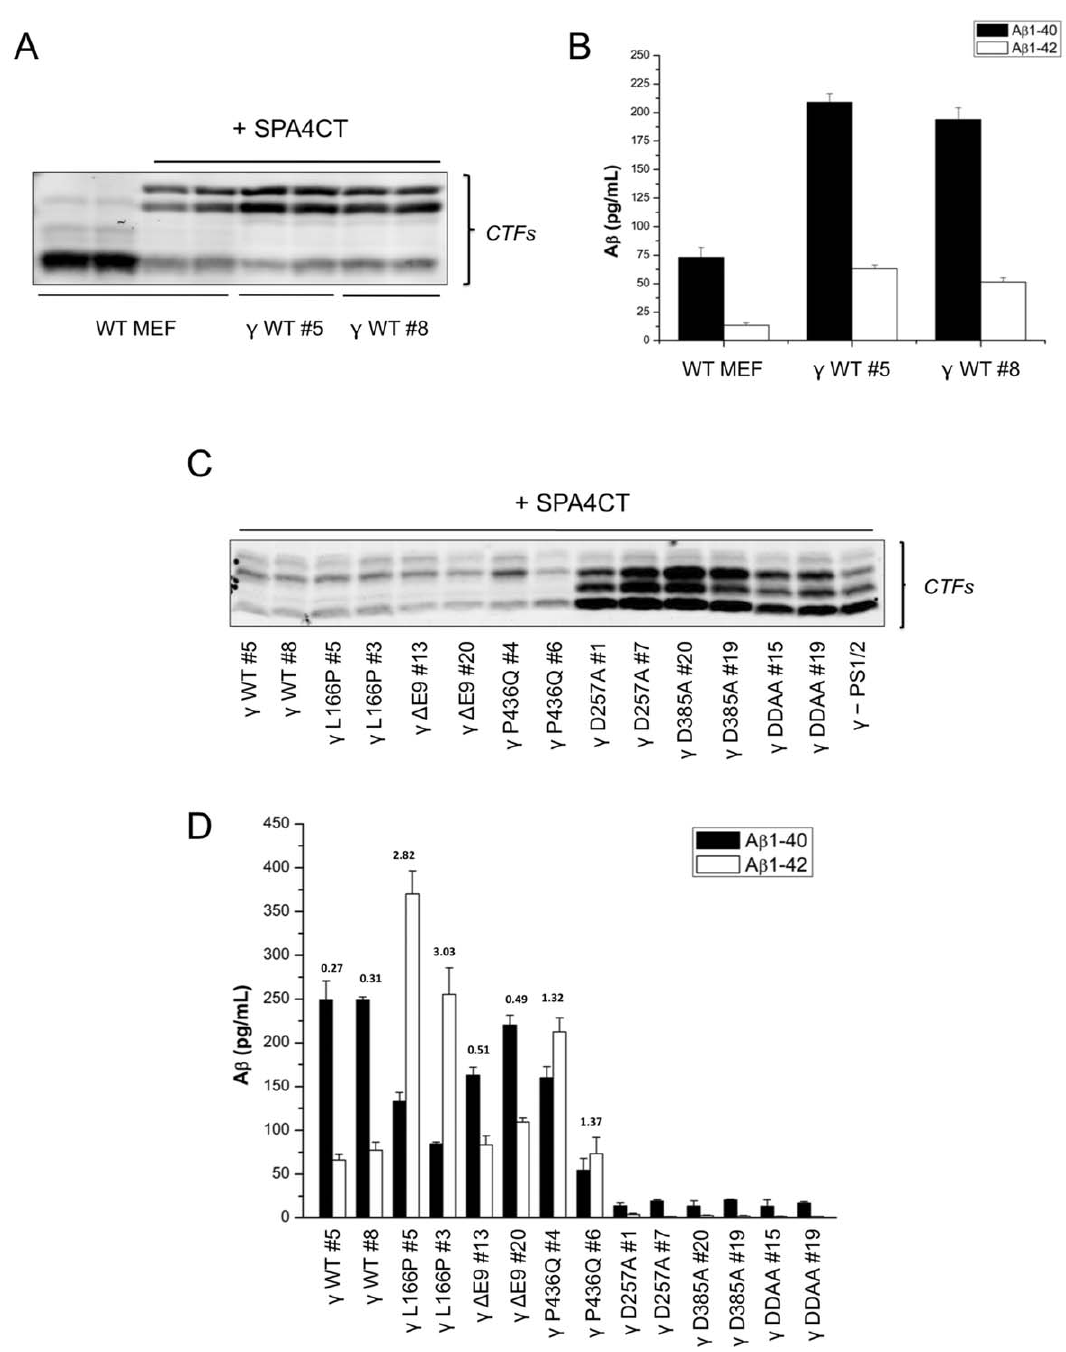
Figure 2. A b production in cell lines overexpressing human c -secretase components with FAD-linked PS1 variants. WT MEF, c -MEF and c - PS1/2 were transduced with an APP-based substrate corresponding to the 99 C-terminal residues of human APP fused to the APP signal peptide in N-terminus (SPA4CT [36]) and a Flag Tag in C-terminus. Cell proteins were extracted in 1% NP40-HEPES buffer, separated by SDS-PAGE on 12% Tris-Glycine gels and analysed by immunostaining with an antibody targeting the C-terminal part of APP (A8717) (A, C). A b 1–40 and A b 1–42 levels were also measured in the corresponding cell culture media (B, D). Data corresponds to three independent experiments (Mean 6 SEM). doi:10.1371/journal.pone.0035133.g002 transgenic animals with FAD-linked PS1 mutations show increas- patients with PSEN1 mutations [43]. This was further validated in vivo as the overexpression of PS1 mutants in APP transgenic mice specie deposited in the brain of AD patients [16,39], is more prone accelerated the rate of A b accumulation and deposition in the brain [44,45]. However, Bentahir and colleagues challenged this has been implicated in the seeding of amyloid plaques in AD view by showing that several PSEN1 mutations were also capable